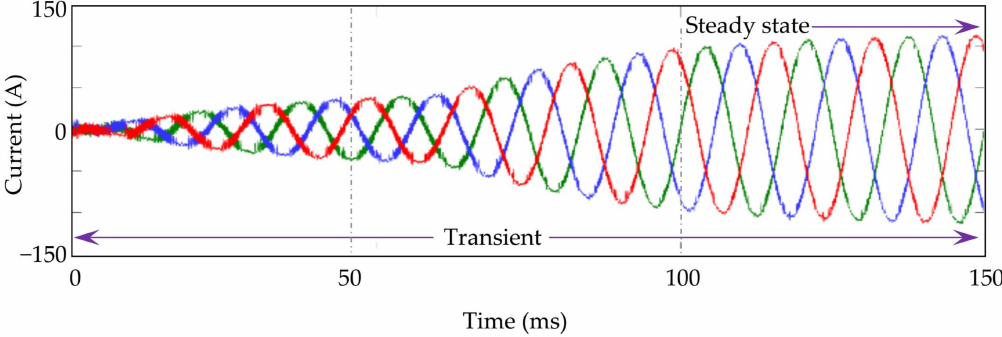
Figure 16. Current waveform for controlling the active